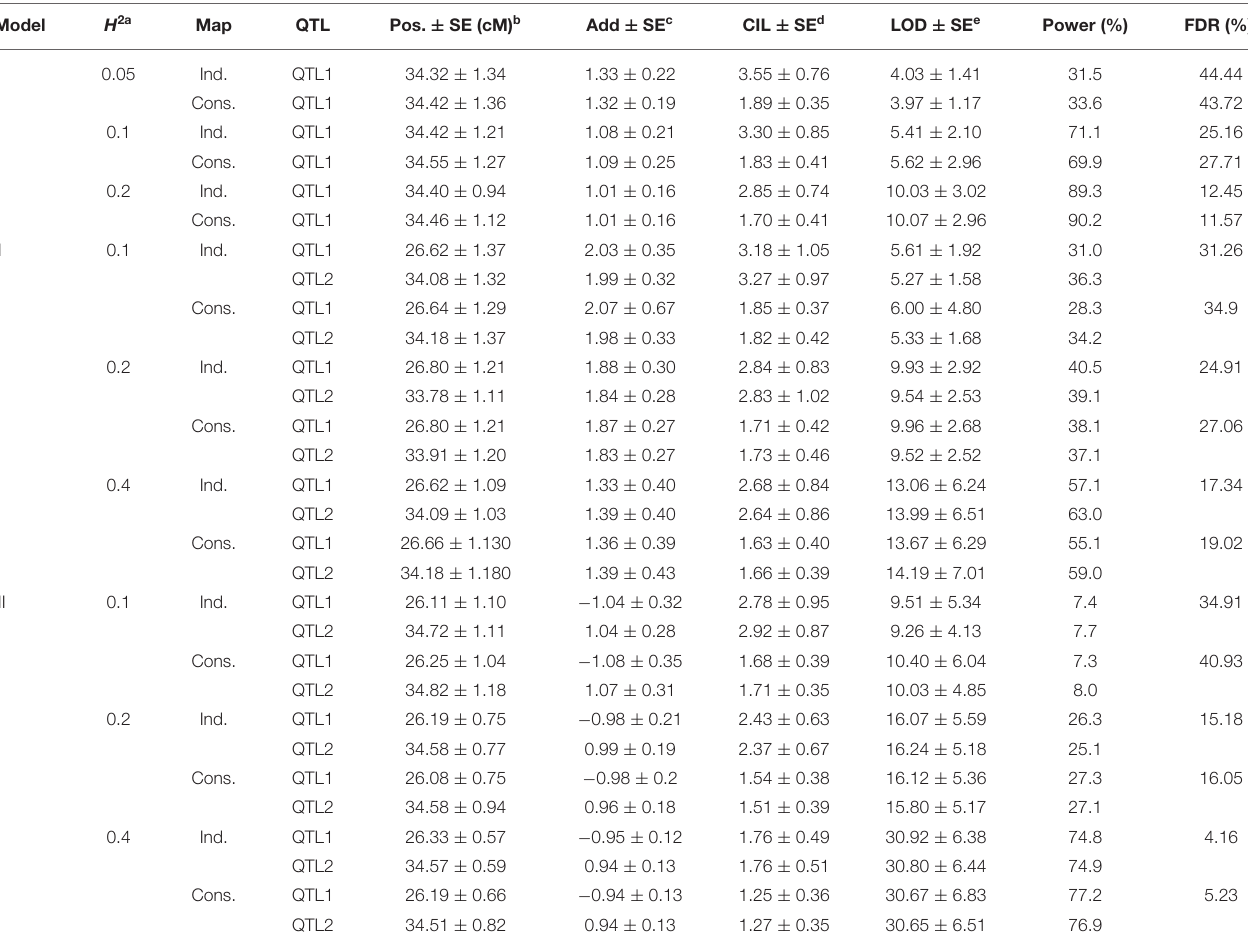
TABLE 6 | Quantitative trait locus mapping results from 1,000 simulations using the individual and consensus maps in the three genetic models.